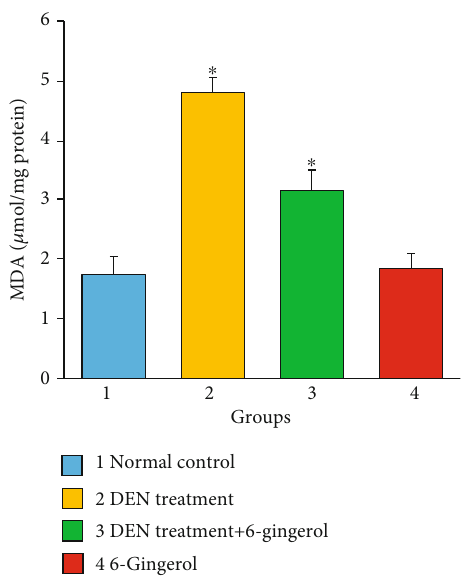
Figure 9: E ff ects of DEN exposure on hepatic lipid peroxidation. The formation of malondialdehyde (MDA) was analyzed in control, disease control (DEN treated), DEN+6-gingerol treatment, and only 6-gingerol treatment groups. Each bar represents the mean value of experiments performed in triplicate ± SEM ( n = 8 , each group). ∗ p < 0 : 05 compared with the control